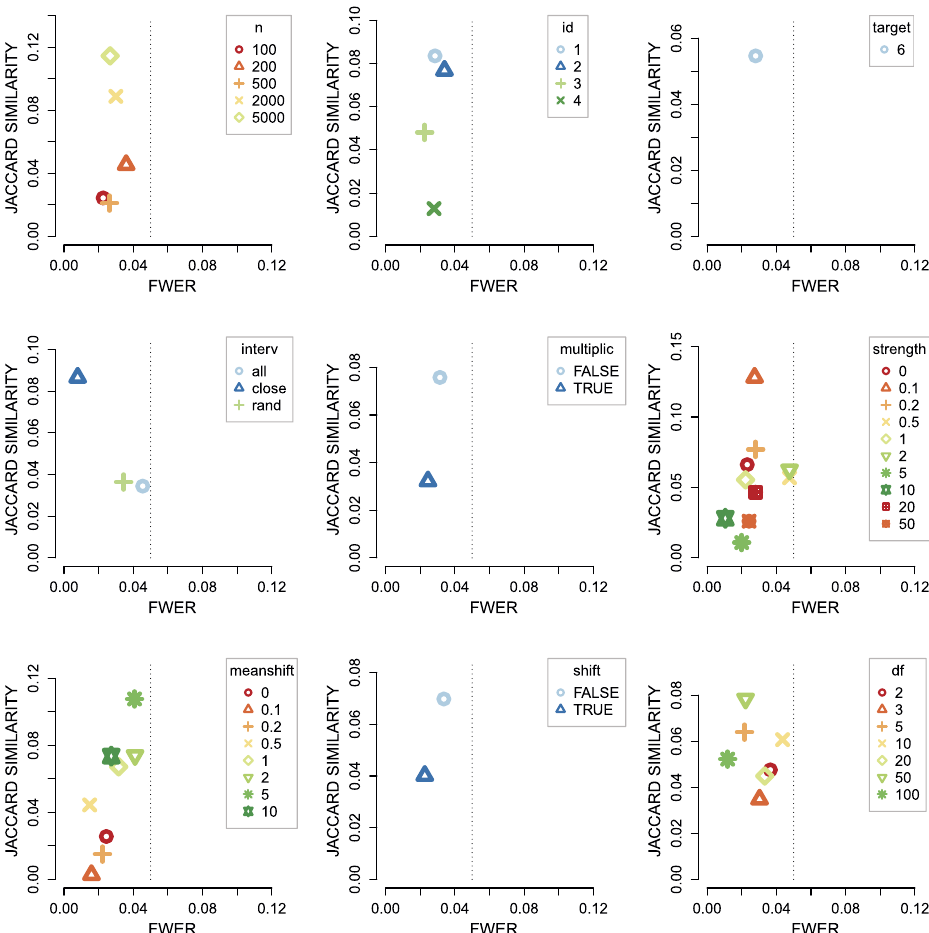
Figure 13: Average Jaccard similarity over the conditional independence tests (A)–(F) (y-axis) against average FWER